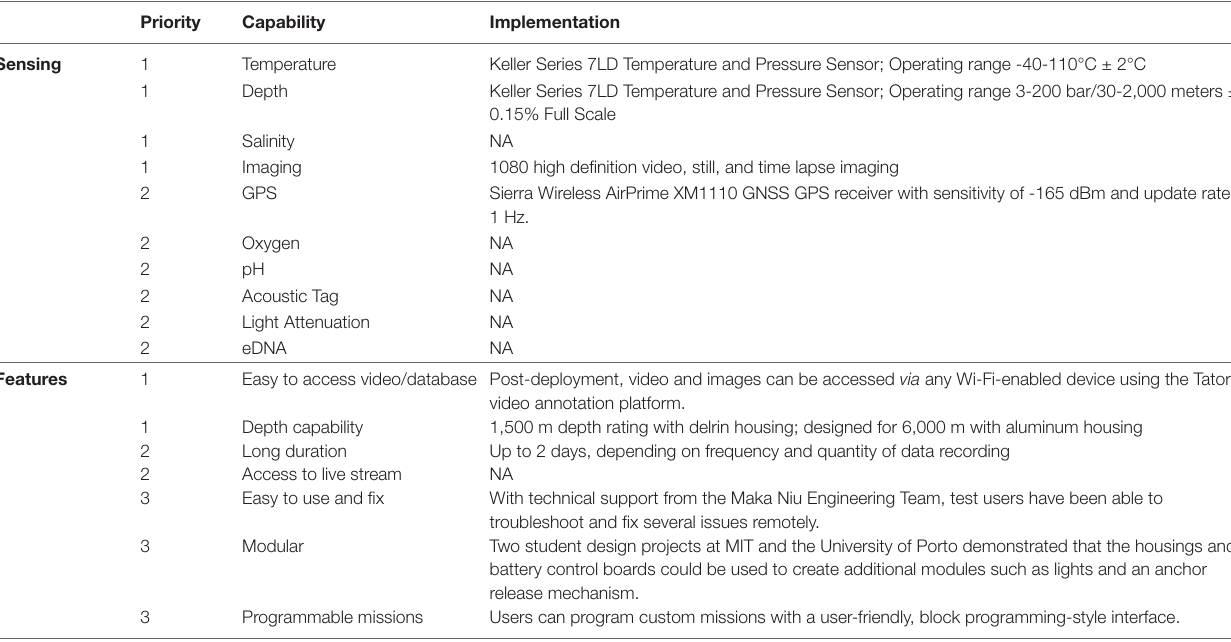
TABLE 3 | Implementation of sensing and feature capabilities for Maka Niu identified during interviews, listed by priority.